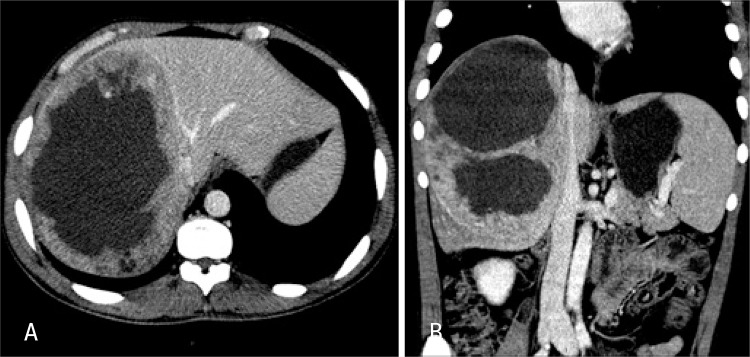
(A) Tomografia computadorizada - corte axial - fase portal - veia hepática media - contato com a lesão. (B) Tomografia computadorizada - corte coronal